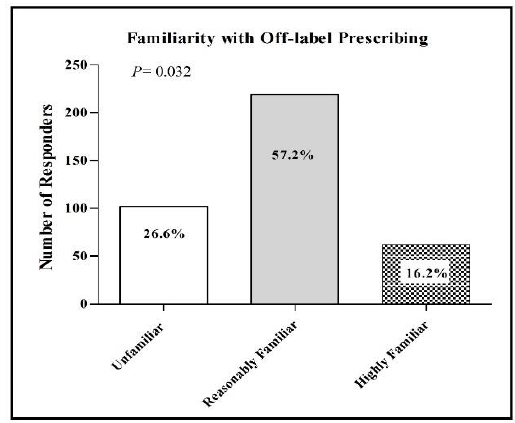
Figure 1. Rating of the targeted physicians according to their familiarity with the off-label prescribing practice. n =383 total number; ( chi- square test ).